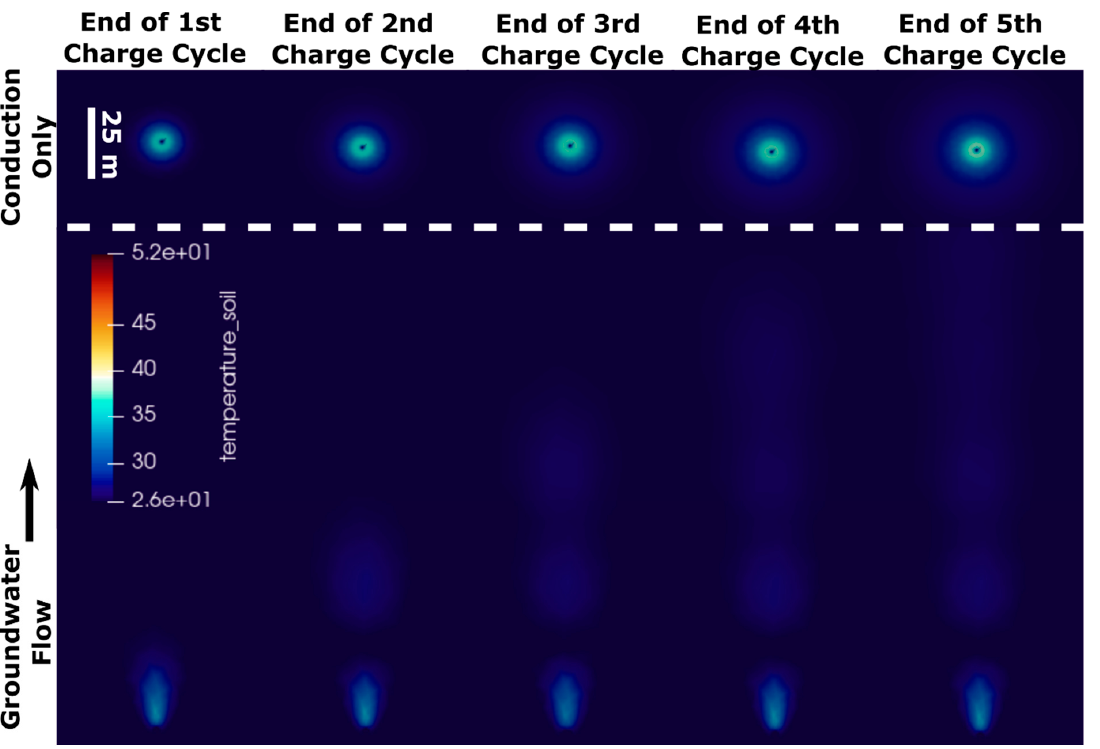
Figure 14. Cross sections in plan view at 500 m depth at the end of the charge period after 5 annual cycles of 6 months charge and discharge. Image shows conductive heat transfer only in the subsur- face and with the influence of groundwater flow (Darcy velocity of 1e-6 m/s).